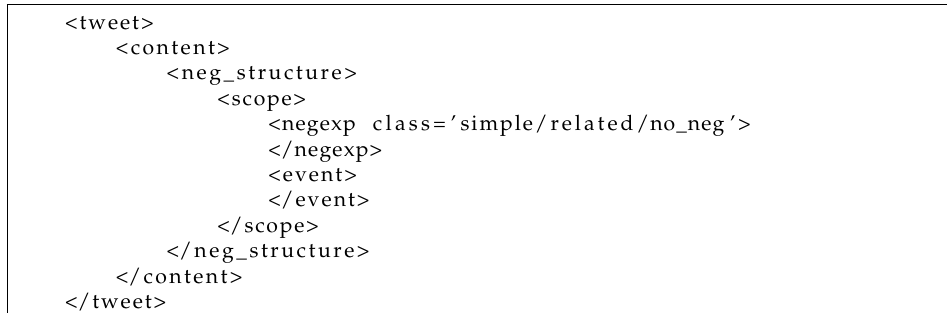
Figure 2. General structure of the negation tagging.